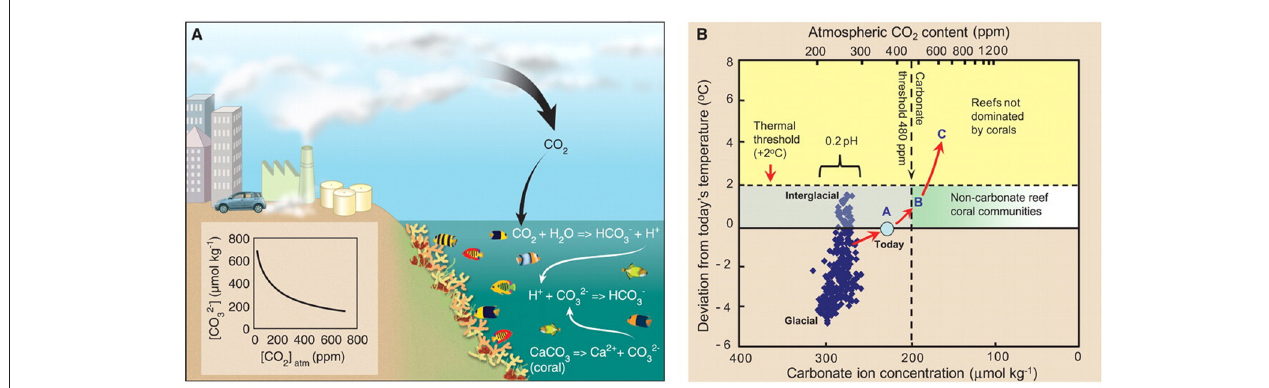
FIGURE 2 | (A) Linkages between the build-up of atmospheric CO 2 and the slowing of coral calcification due to ocean acidification. Approximately 30% of the atmospheric CO 2 emitted by humans has been taken up by the ocean (IPCC, 2013) where it combined with water to produce carbonic acid, which releases a proton that combines with a carbonate ion. This decreases the concentration of carbonate, making it unavailable to marine calcifiers such as corals. (B) Temperature, [CO 2 ] atm , and carbonate-ion concentrations reconstructed for the past 420,000 years. Carbonate concentrations were calculated (Lewis et al., 1998) from [CO 2 ] atm and temperature deviations from conditions in the decade of the 2000s with the Vostok Ice Core data set ( Petit et al., 1999), assuming constant salinity (34 parts per trillion), mean sea temperature (25 ◦ C), and total alkalinity (2,300 mmol kg − 1 ). Acidity of the ocean varies by ± 0.1 pH units over the past 420,000 years (individual values not shown). The thresholds for major changes to coral communities are indicated for thermal stress ( + 2 ◦ C) and carbonate-ion concentrations ([carbonate] = 200 µ mol kg − 1 , approximate aragonite saturation ∼ (cid:127) aragonite = 3.3; [CO 2 ] atm = 480 ppm). Coral Reef Scenarios CRS-A, CRS-B, and CRS-C are indicated as A, B, and C, respectively, with analogs from extant reefs. Red arrows pointing progressively toward the right-hand top square indicate the pathway that is being followed toward [CO 2 ] atm of more than 500 ppm. From Hoegh-Guldberg et al. (2007) with permission of Science Magazine.